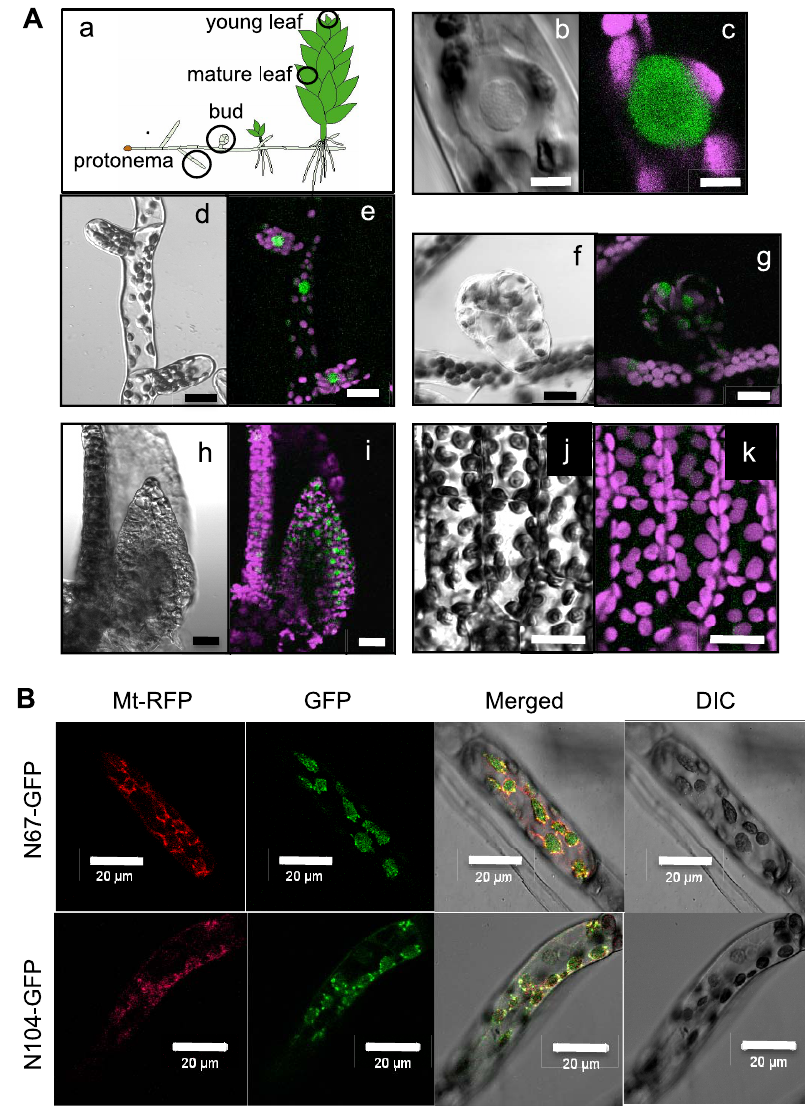
Figure 2. Localization of PpPPR_63, 67, and 104. ( A ) Observations of GFP fluorescence in various cells and tissues of the stable transgenic moss KI-10 line expressing PpPPR_63-GFP fusion protein. Schematic diagram of a moss plant and observed parts are in circles (a). Images are differential interference contrast (DIC) (b, d, f, h, j) and GFP (green) and chlorophyll (magenta) fluorescence (c, e, g, i, k). Single protonemal cell (b, c), protonemal cells (d, e), a bud (f, g), a young leaf (h, i), and mature leaf cells (j, k). Scale bars =5 m m (b, c) or 20 m m (d–k). ( B ) Subcellular localization of N-terminal PpPPR_67-GFP fusion protein (N67-GFP, upper panels) or N-terminal PpPPR_104-GFP fusion protein (N104-GFP, bottom panels). For mitochondrial localization control, the c subunit of mitochondrial ATPase and RFP fusion protein (Mt-RFP) was used. Fluorescence of GFP and RFP, the overlay of the two fluorescence images (Merged), and the corresponding Nomarski images (DIC) are shown.